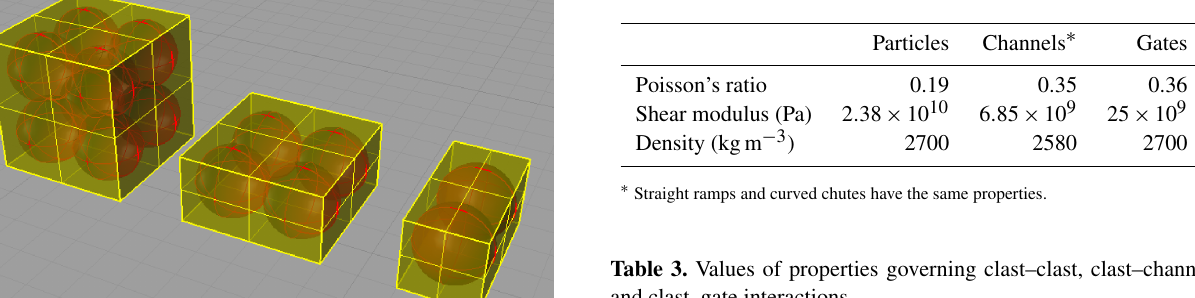
Table 2. Physical properties of materials.